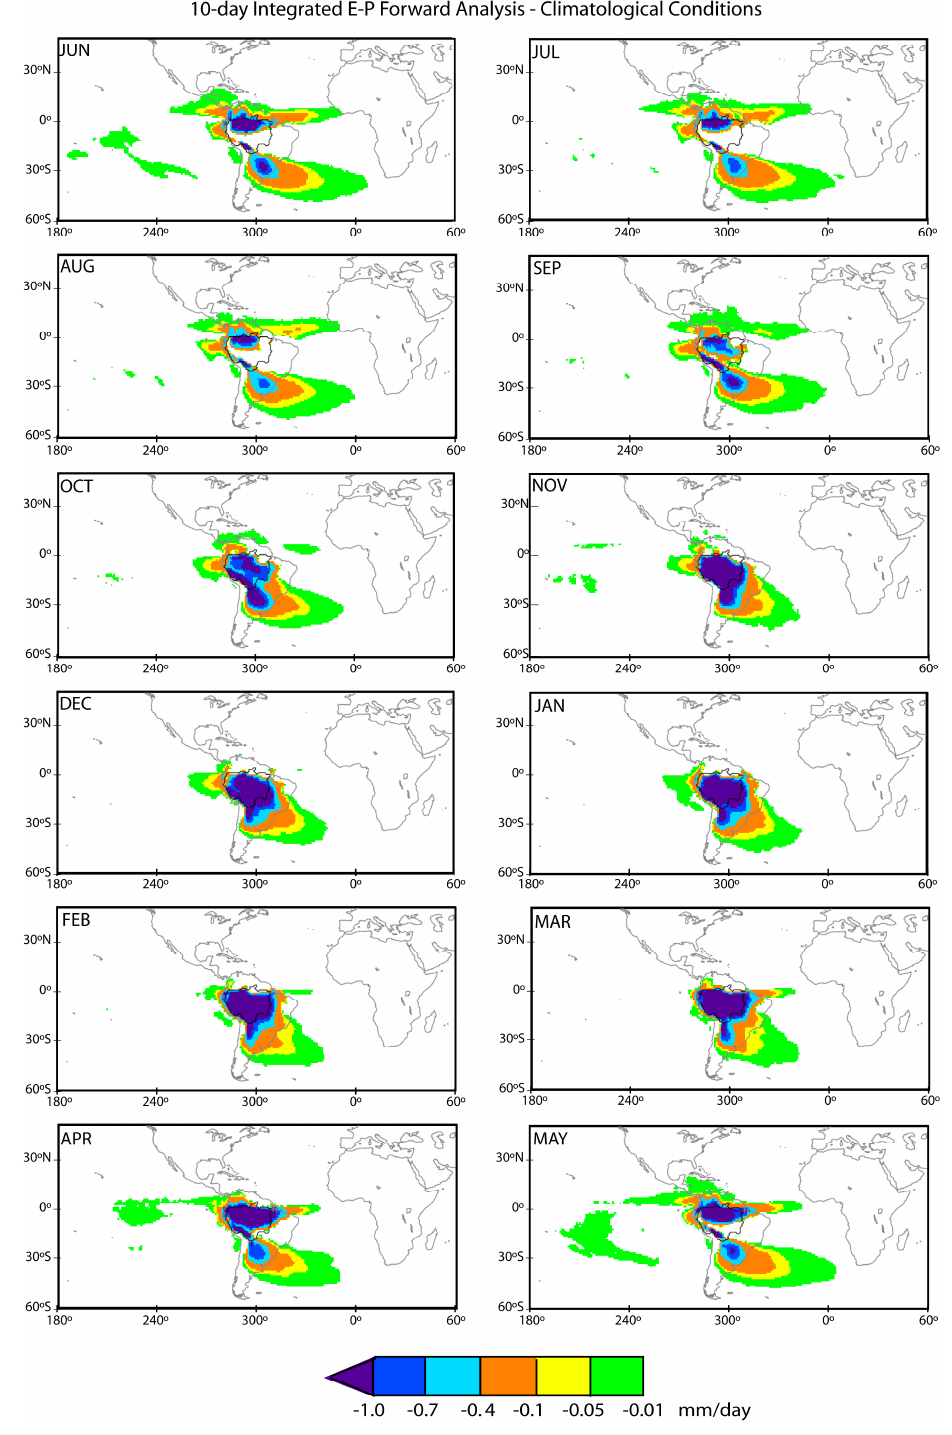
Figure 3 1 Figure 3. Climatological monthly 10-day integrated ( E − P ) fields obtained through the forward Amazon experiment for the period June 1979–May 2012. Only negative values are shown in order to emphasise the sink regions. Black contour line indicates the basin